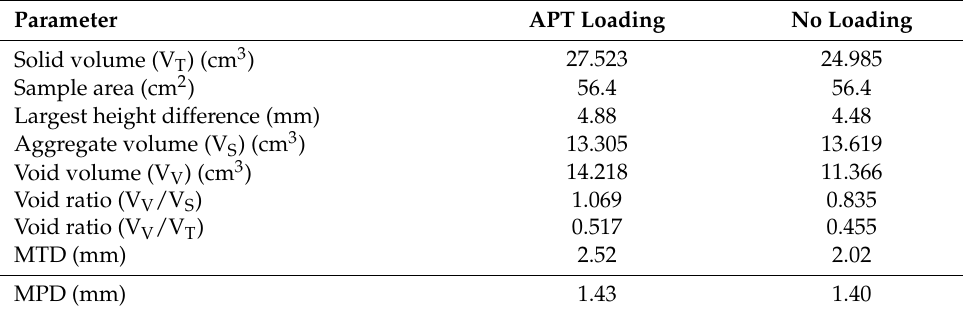
Figure 18. Height maps generated from the 3D scan of the area subjected to standard APT loading in order to assess the rut of the Cape seal. Table 6. Volume and void ratios calculated from a statistical analysis of the 3D data sets of the 24 h test done on the Cape seal.